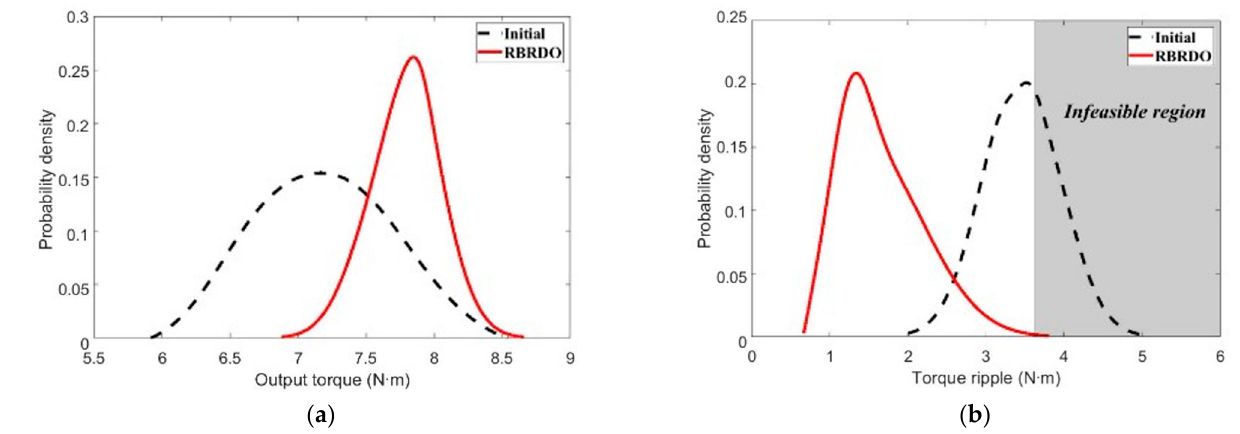
Figure 12. Comparison of probability distribution results of ( a ) output torque and ( b ) torque ripple in the initial design and RBRDO.